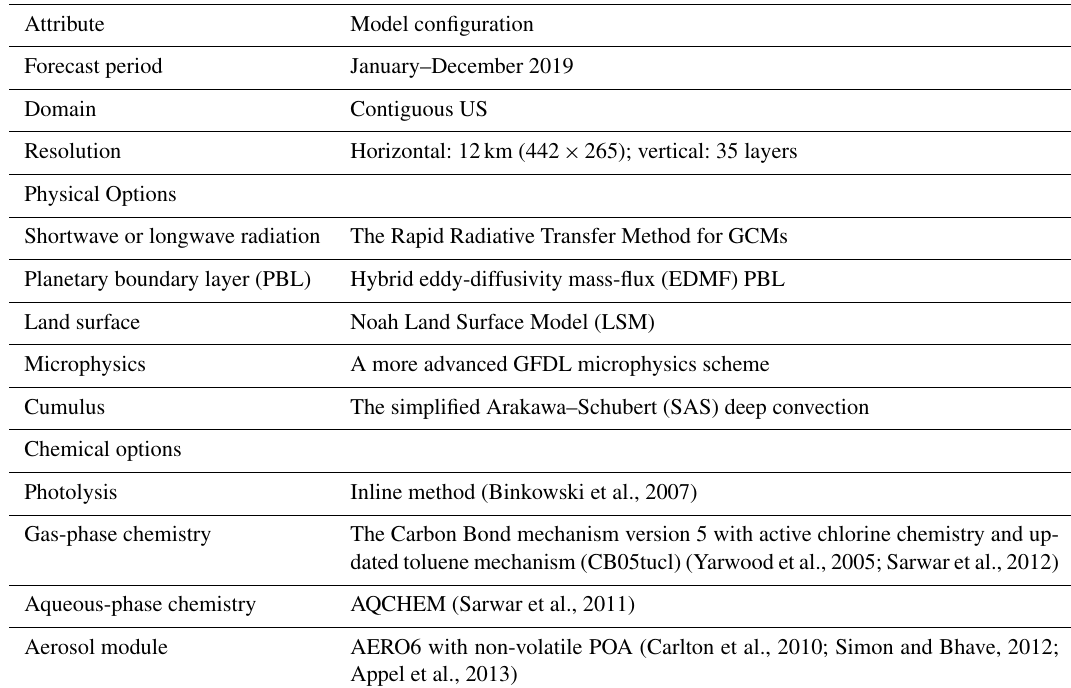
Table 1. Configuration of GFSv15–CMAQv5.0.2 system.